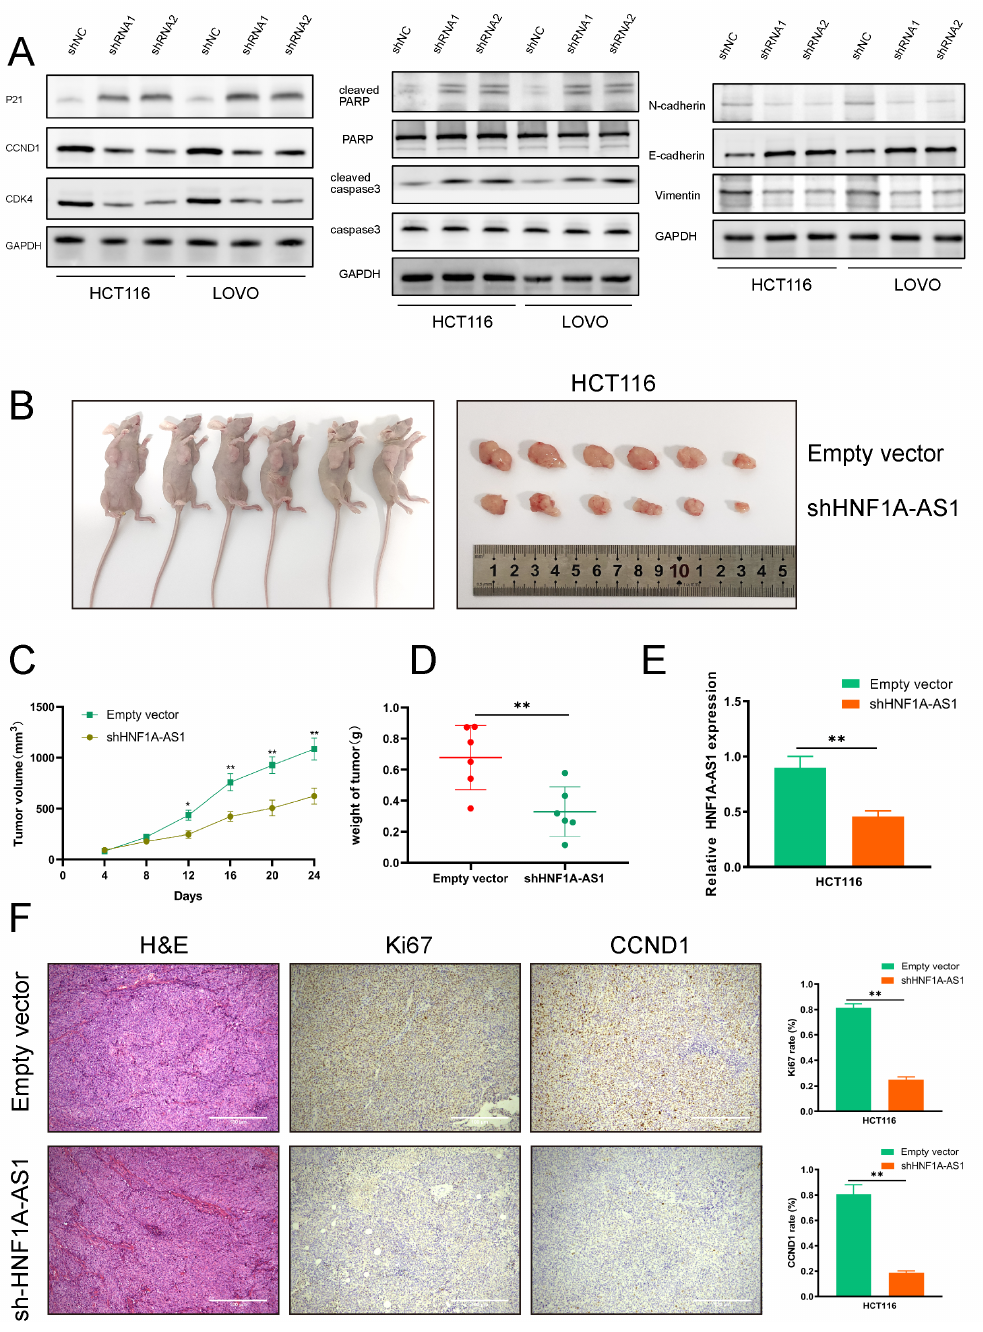
Figure 3. HNF1A-AS1 accelerated tumor growth of CRC in vivo. ( A ) Cell cycle check point proteins (p21, CCND1, CDK4), apoptosis-related proteins (caspase3, cleaved-caspase3, PARP, cleaved PARP) and epithelial-mesenchymal transition (EMT)-associated proteins (N-cadherin, E-cadherin,